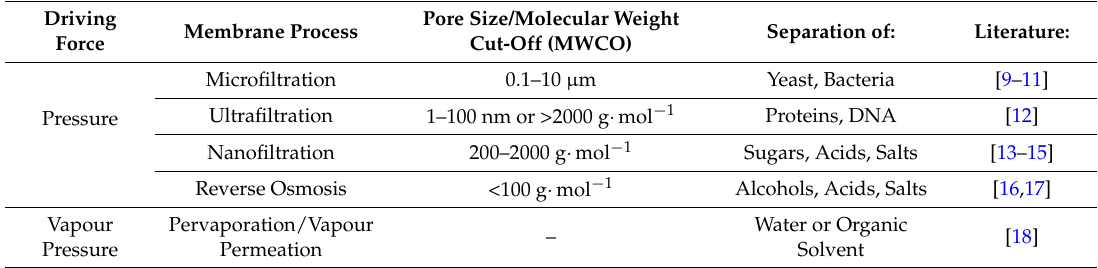
Table 1. Application of different membrane processes for separations within microbial fermentation.